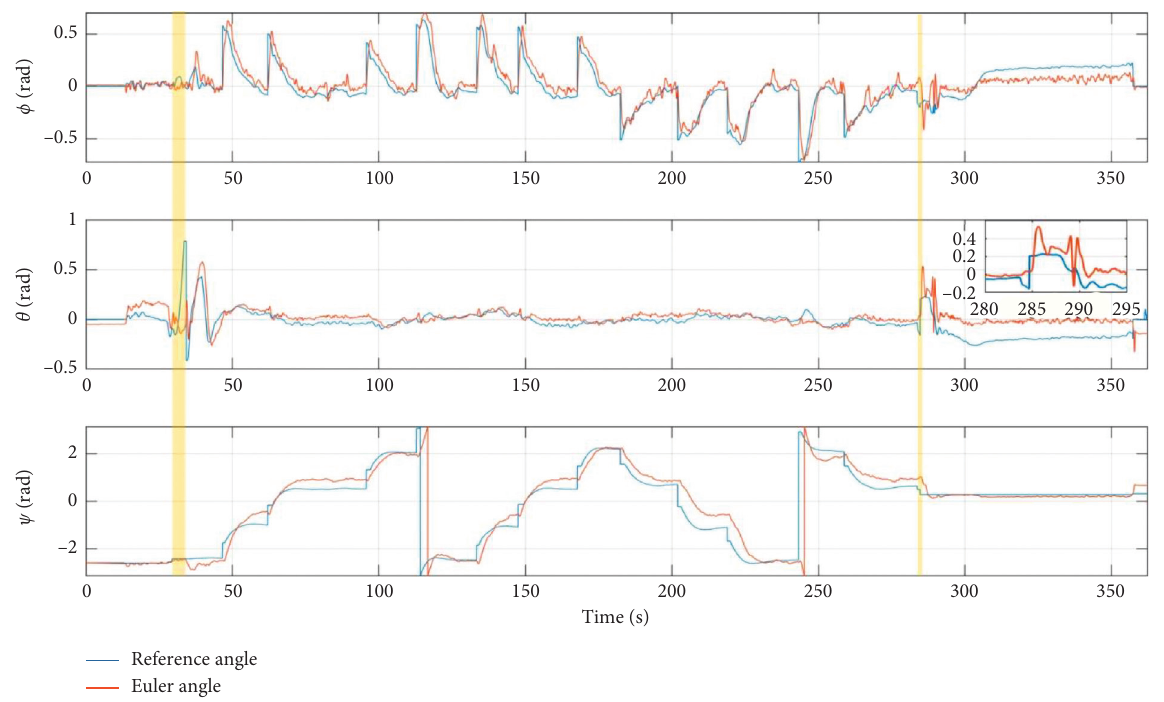
Figure 21: Attitude of the aircraft in the flight experiment.